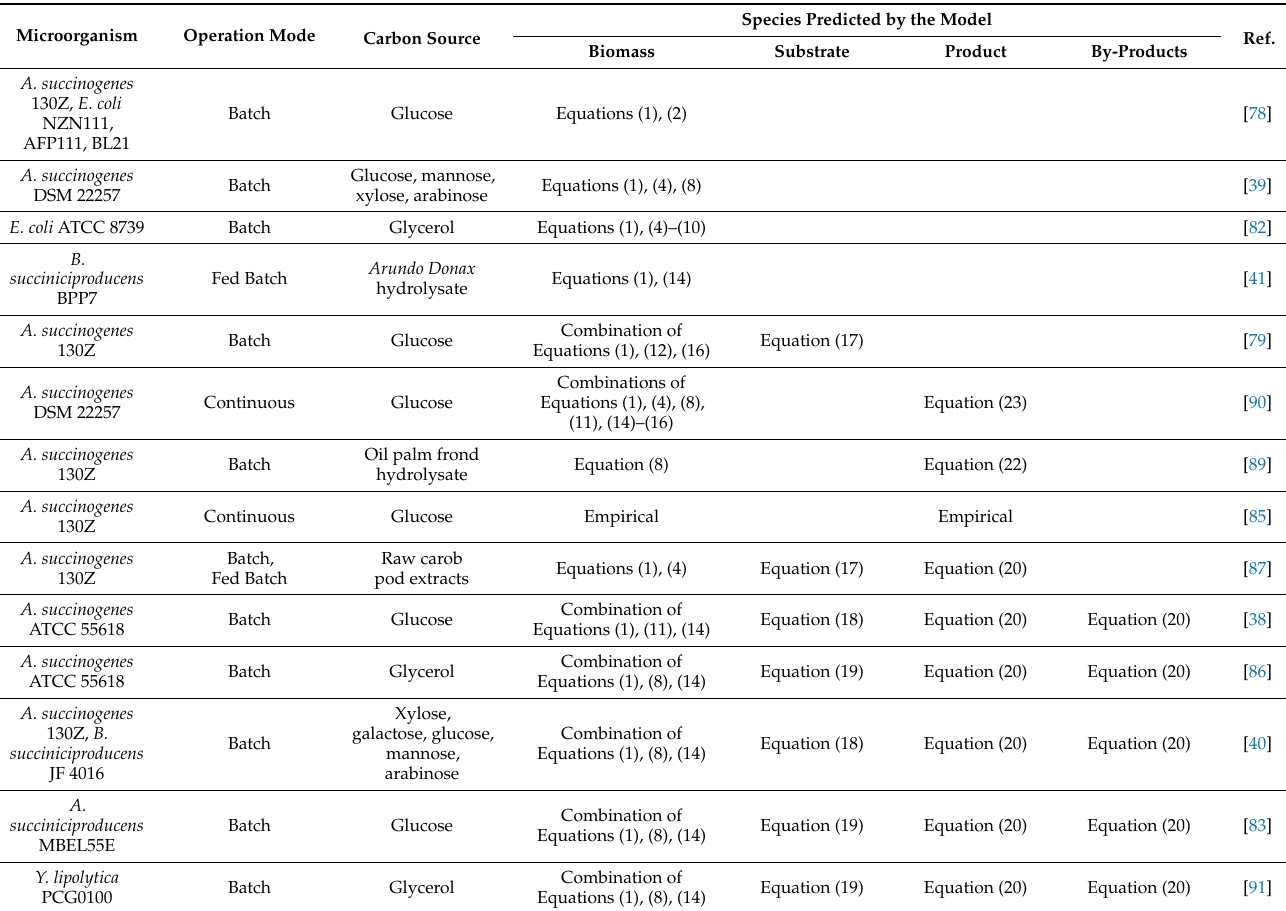
Table 1. Non-segregated unstructured kinetic